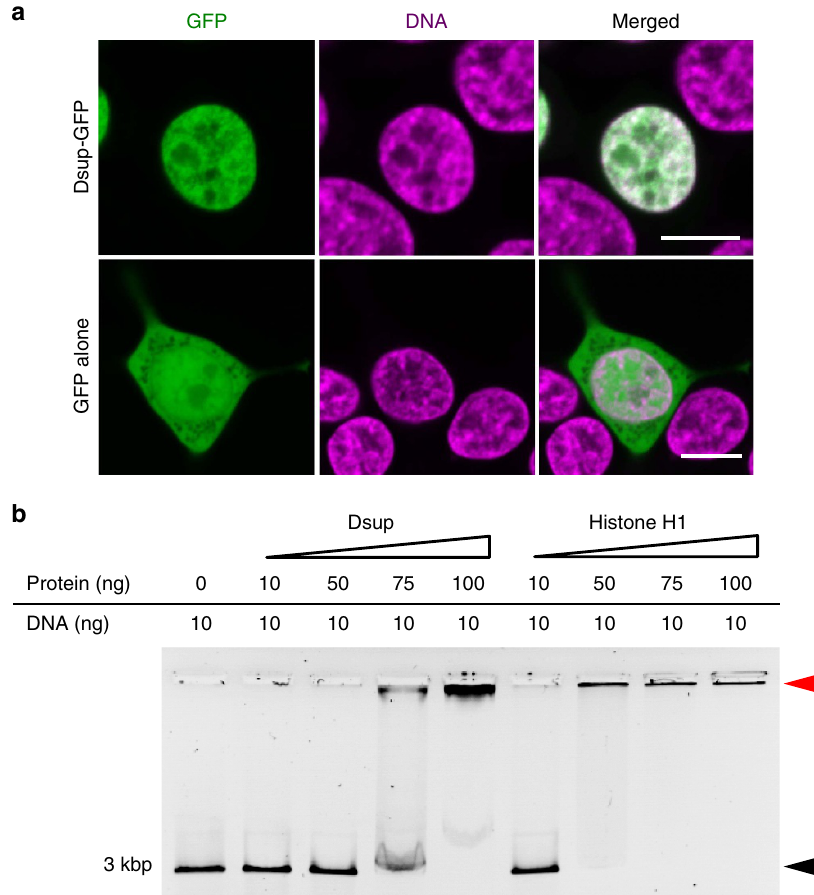
Figure 3 | Co-localization with nuclear DNA and mobility shift of DNA by Dsup. ( a ) Subcellular localization of Dsup-GFP fusion proteins transiently expressed in HEK293T cells. Nuclear DNA was visualized by Hoechst 33342. Scale bars, 10 m m. ( b ) Mobility shift of DNA by bacterially expressed Dsup protein in a dose-dependent manner (10, 50, 75 or 100ng). Black arrowhead indicates the predicted size of the probe DNA (3kbp, 10ng). Red arrowhead indicates the position of the extremely slowly migrating DNA in the presence of Dsup protein. A similar extensive mobility shift was observed with histone